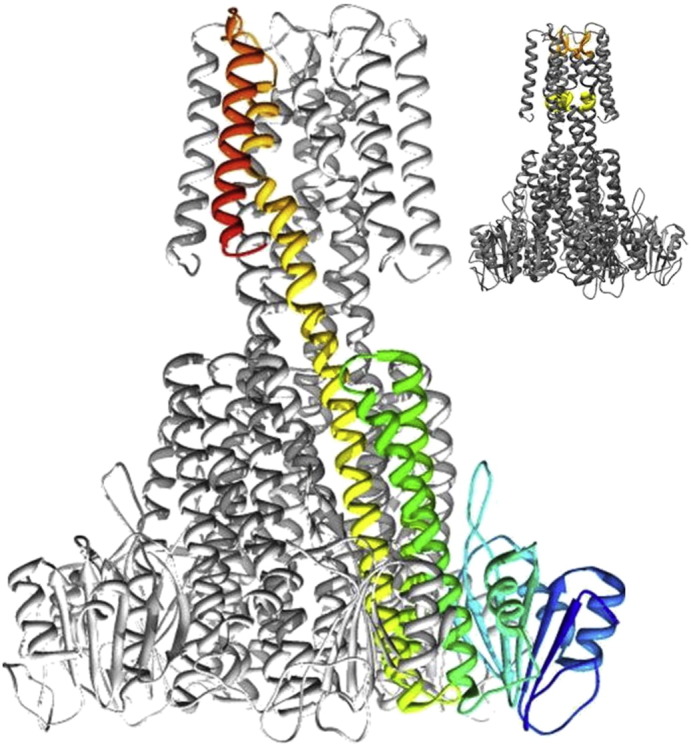
The crystal structure of MjCorA: The crystal structure of MjCorA [12] rendered with UCSF Chimera [34] (PDB ID: 4EV6). The protein is shown in a cartoon representation with β-sheets and α-helices highlighted as rounded ribbons. One of the five protomer subunits is picked out in colour. The colouring scheme indicates the sequence of the peptide from amino-terminus (dark blue) through cyan, green yellow and orange to red at the carboxy-terminus. With reference to the text; (1) The N-terminal domain is therefore coloured in shades of blue/cyan, (2) the conical domain in green/yellow and (3) the TM domain in orange/red. Inset: A similar image of the crystal structure with the location of YGMNF motifs picked out in orange and TMVTT motifs picked out in yellow.